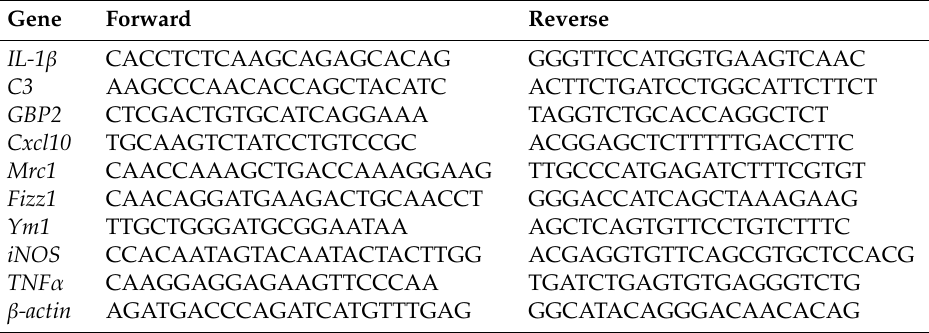
Table 1. DNA sequences of the primers used for RT-PCR.